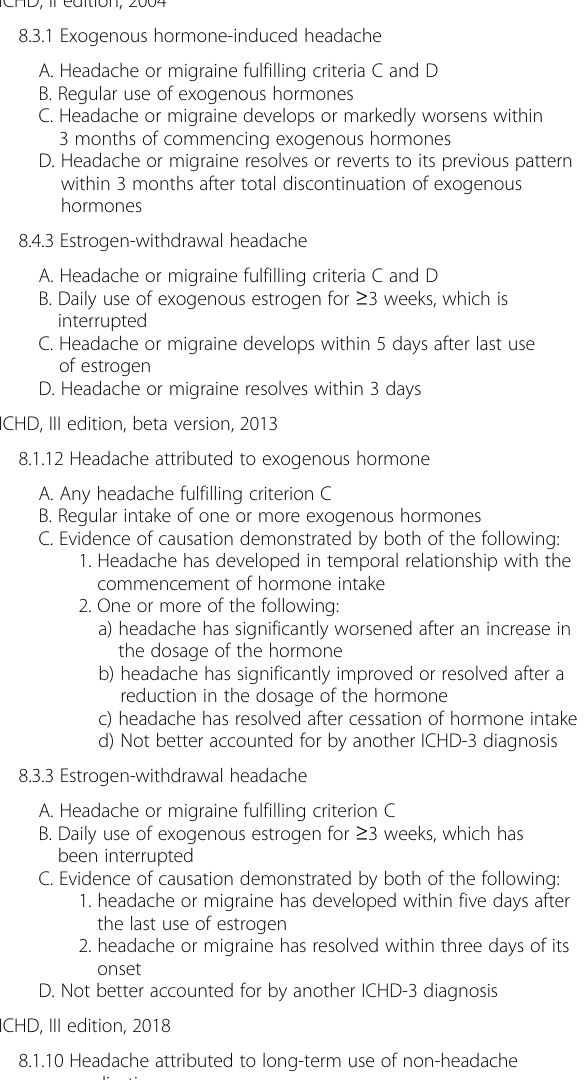
Table 2 Diagnostic criteria of headache related to the use and to the withdrawal of hormones according to the different editions of the International Classification of Headache Disorders (ICHD)